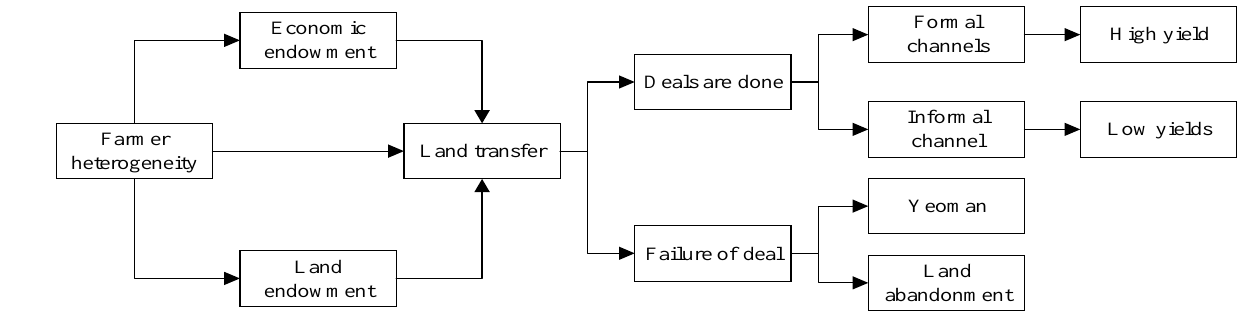
Figure 1. Theoretical analysis of household heterogeneity affecting land transfer.